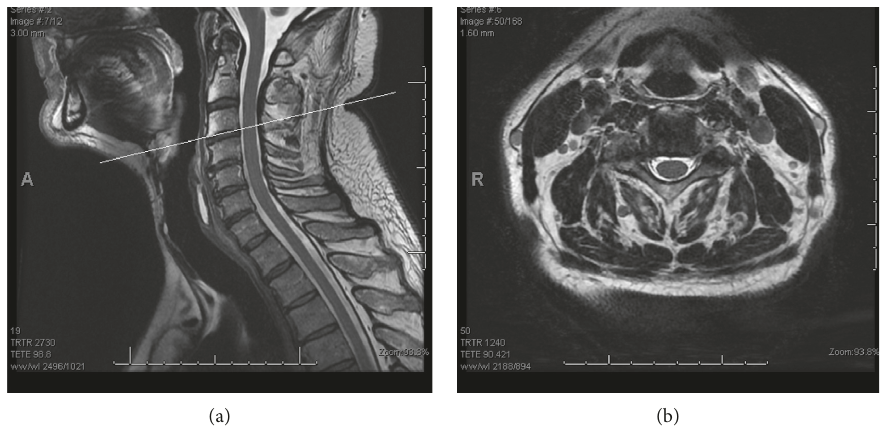
Figure 3: Preoperative T2-weighted sagittal MRI scan at the C3/4 level with corresponding axial sequence illustrating right-sided foraminal stenosis due to a combination of disc bulge, uncovertebral osteophyte, and facet joint hypertrophy.